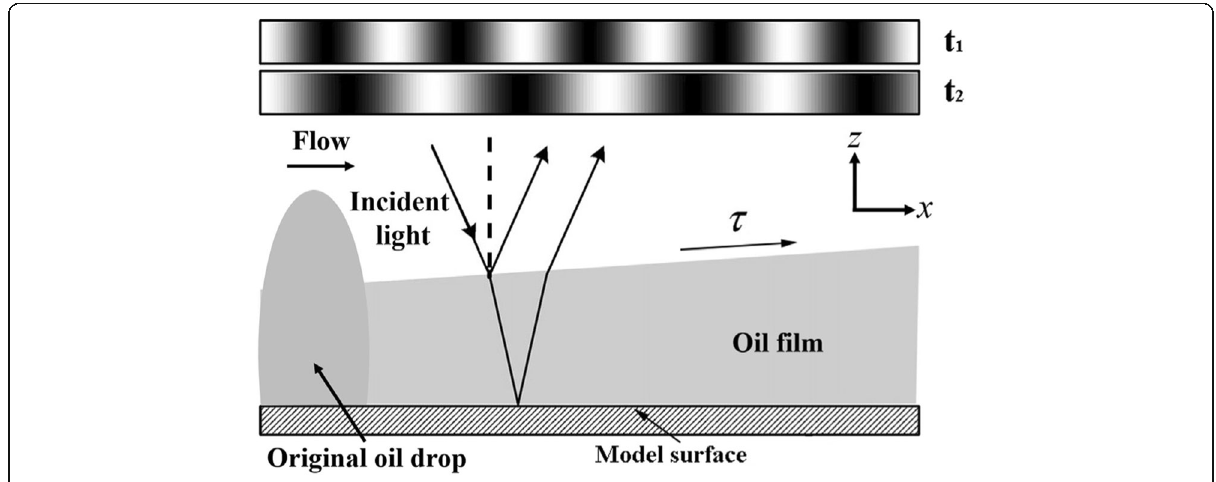
Fig. 2 Summary of the process of the